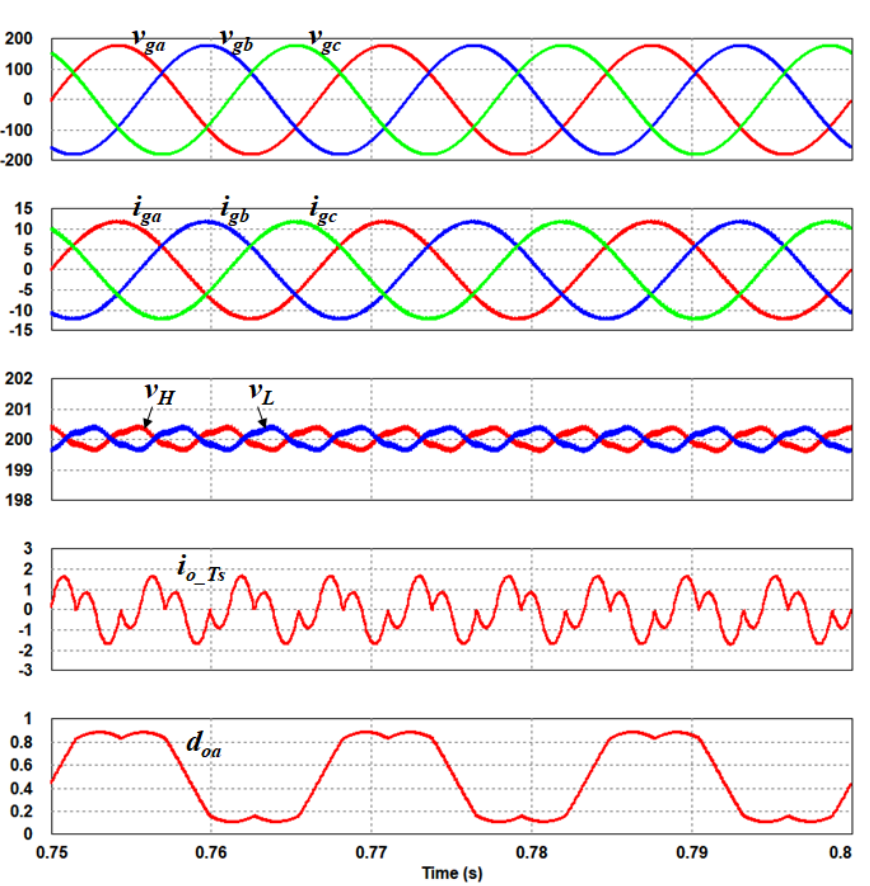
Energies 2021 , 14 , x FOR PEER REVIEW Figure 6. Operational waveforms under balanced load condition. Figure 6. Operational waveforms under balanced load condition.